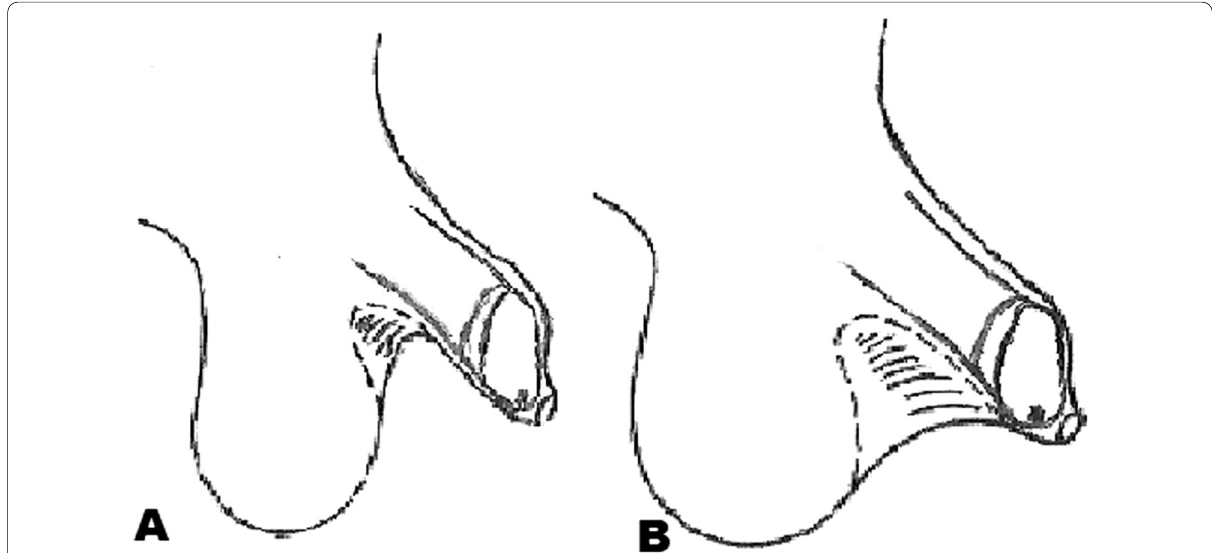
Fig. 2 Simple web penis demonstrates moderate penoscrotal